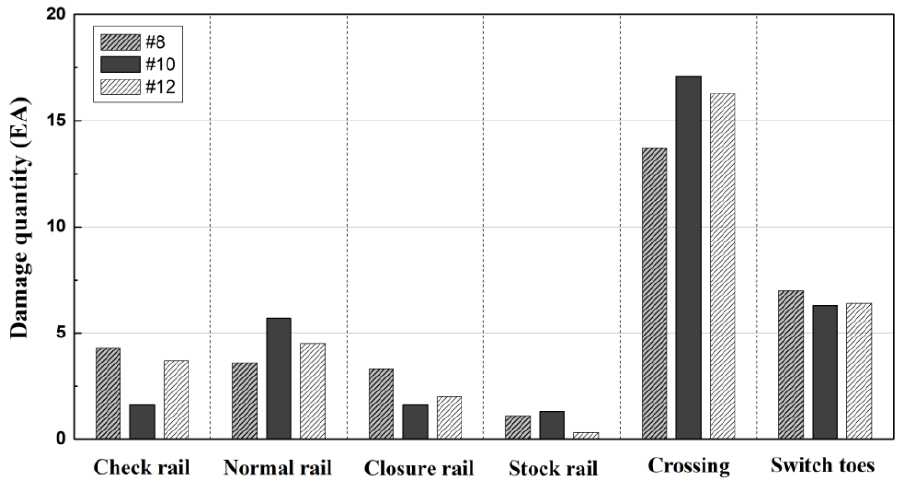
Figure 10. Ranking of damage quantities by rail type.